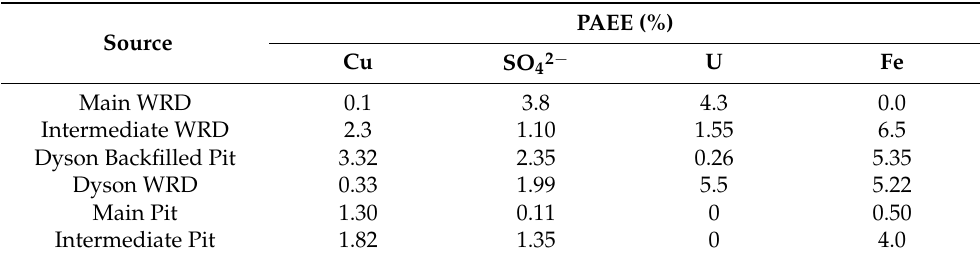
Table 7. Comparison of percent average estimation error (PAEE, %) obtained for species at distributed source locations using error-free